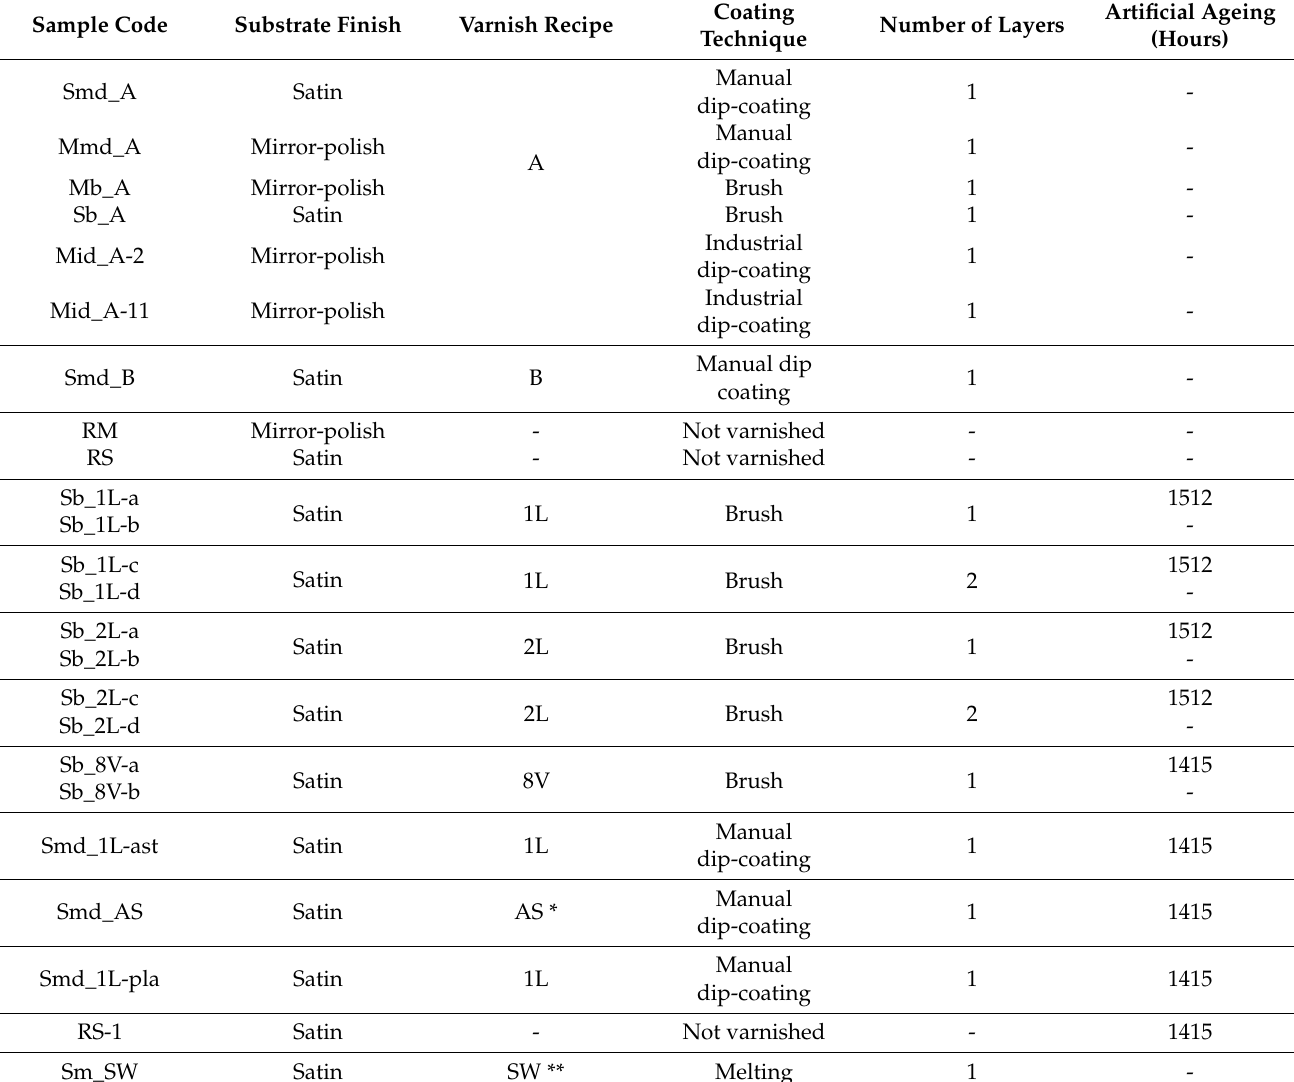
Table 1. Characteristics of the samples analyzed in this study. Varnish recipes are presented in Table 2. Sample code interpretation: 1st letter = type of substrate finish (S = satin, M = mirror-polished); 2nd (and 3rd) letter = coating technique (md = manual dip-coating; id = industrial dip-coating; b = brush; m = melting); letter between underscore and dash = varnish recipe; after the dash (when present) = to discriminate between samples’ duplicates.